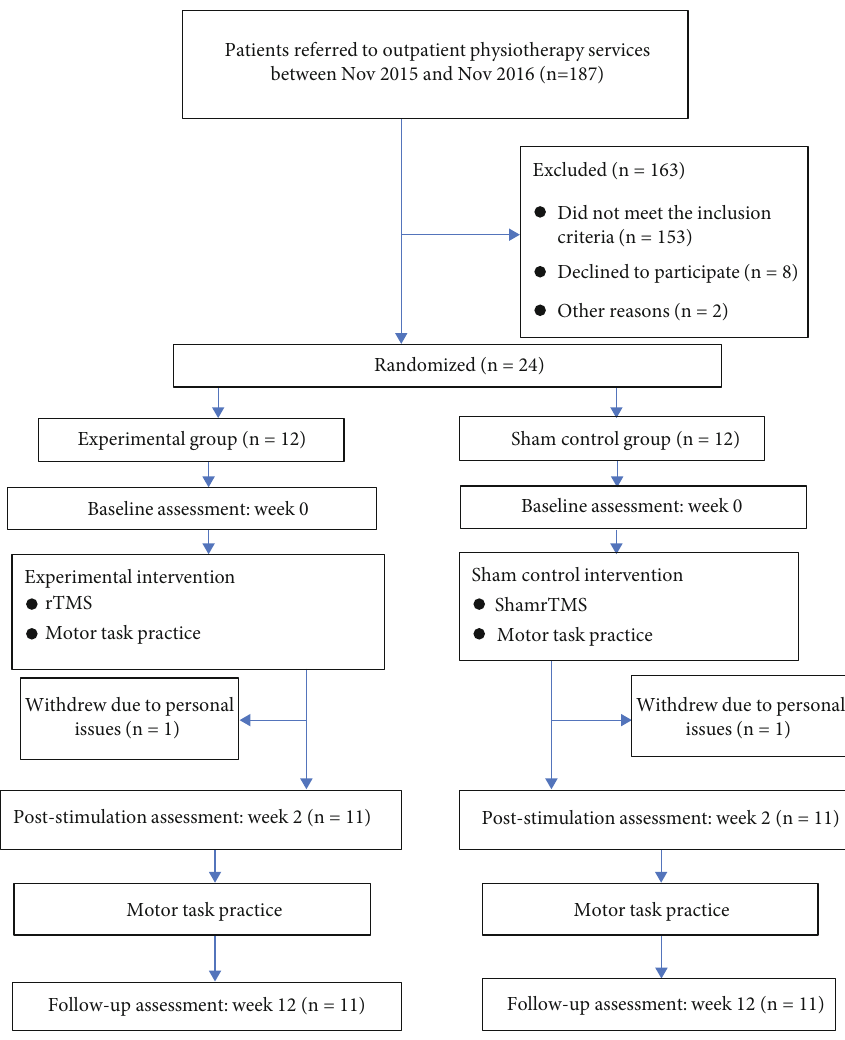
Figure 1: Study fl